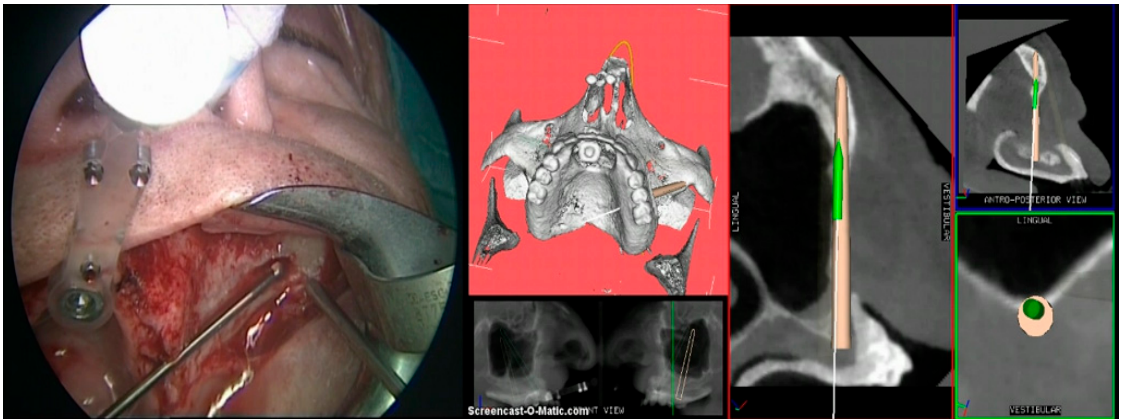
Figure 5. The preparation of the zygomatic implant site following the drill tracking and the planned implant trajectory on the screen of the navigation system (right side) in real time.